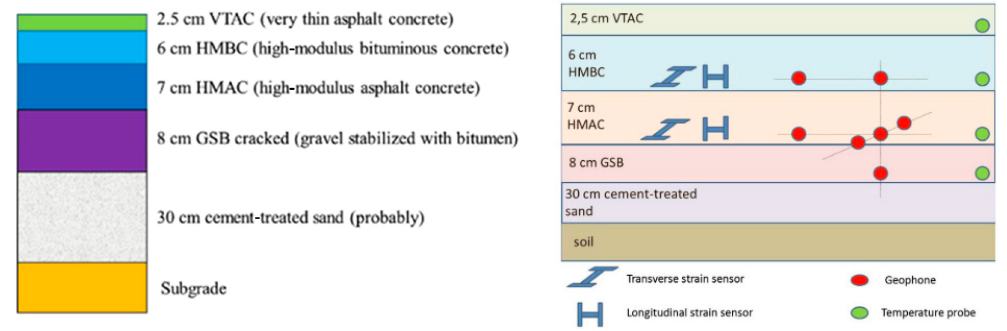
Figure 16. French motorway. ( left ) Pavement structure and ( right ) sensors layout. (figures are reproduced from Duong et al. [46])